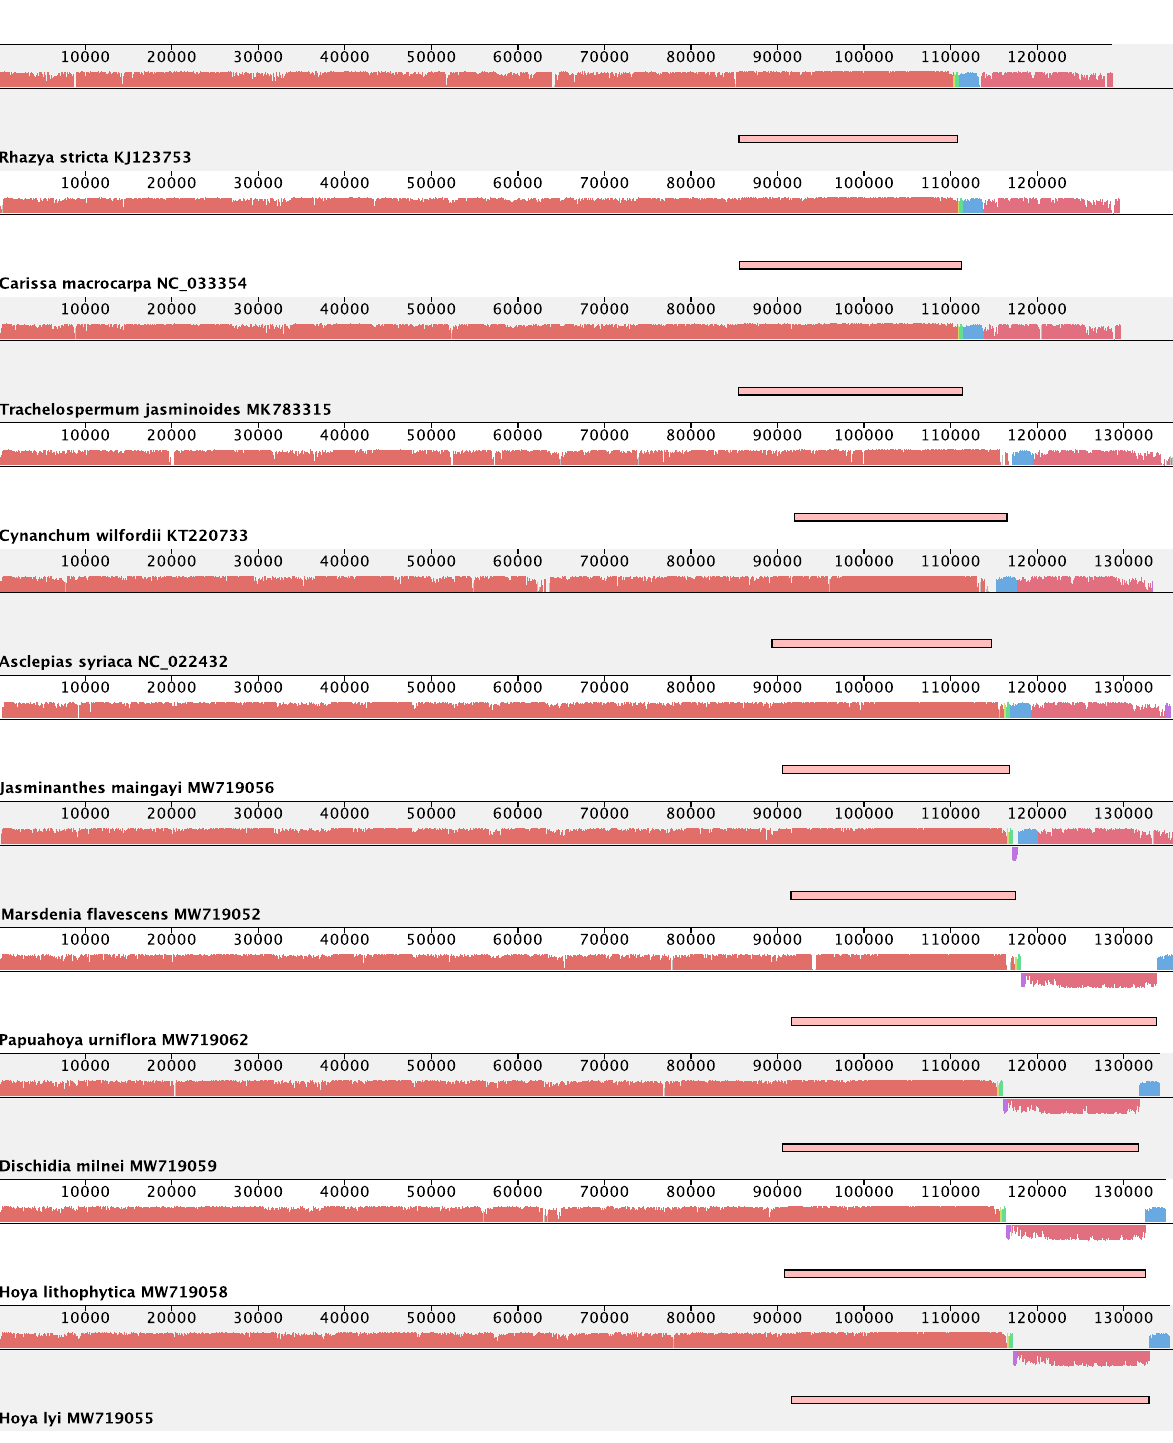
Figure 2. Mauve alignment of plastomes of Hoya group and selected other Apocynaceae species. The inverted repeat closest to psbA was removed, and the small single copy is displayed in a direction that best illustrates the shift in inverted repeat boundaries. The alignment colours refer to locally collinear blocks shared between plastomes. The extent of the inverted repeat is shown with a